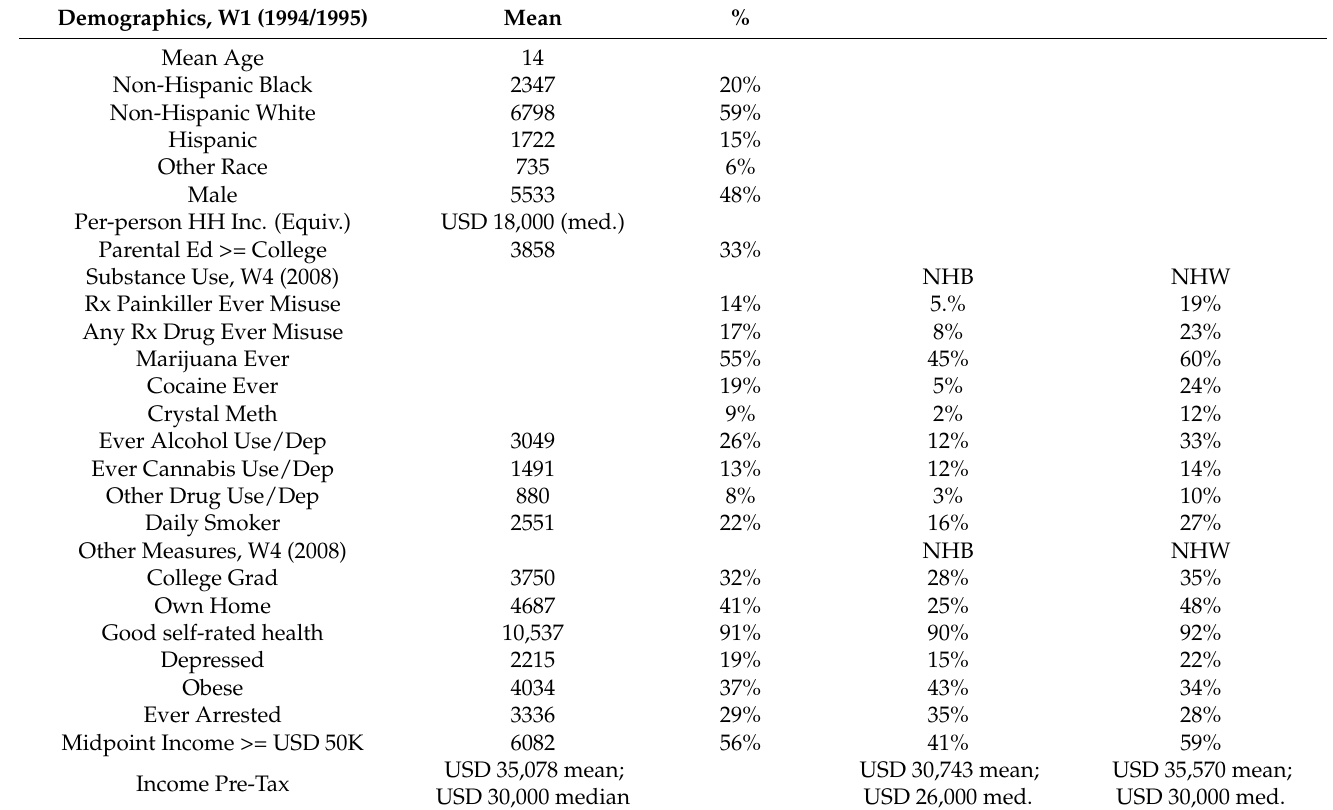
Table 1. Sample characteristics of Add Health (unweighted, n =